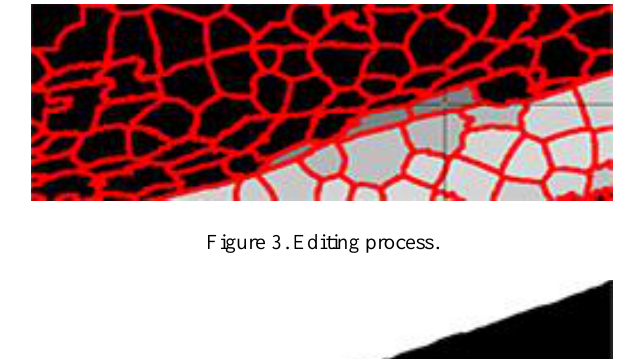
Table 1. Thresholding parameters.